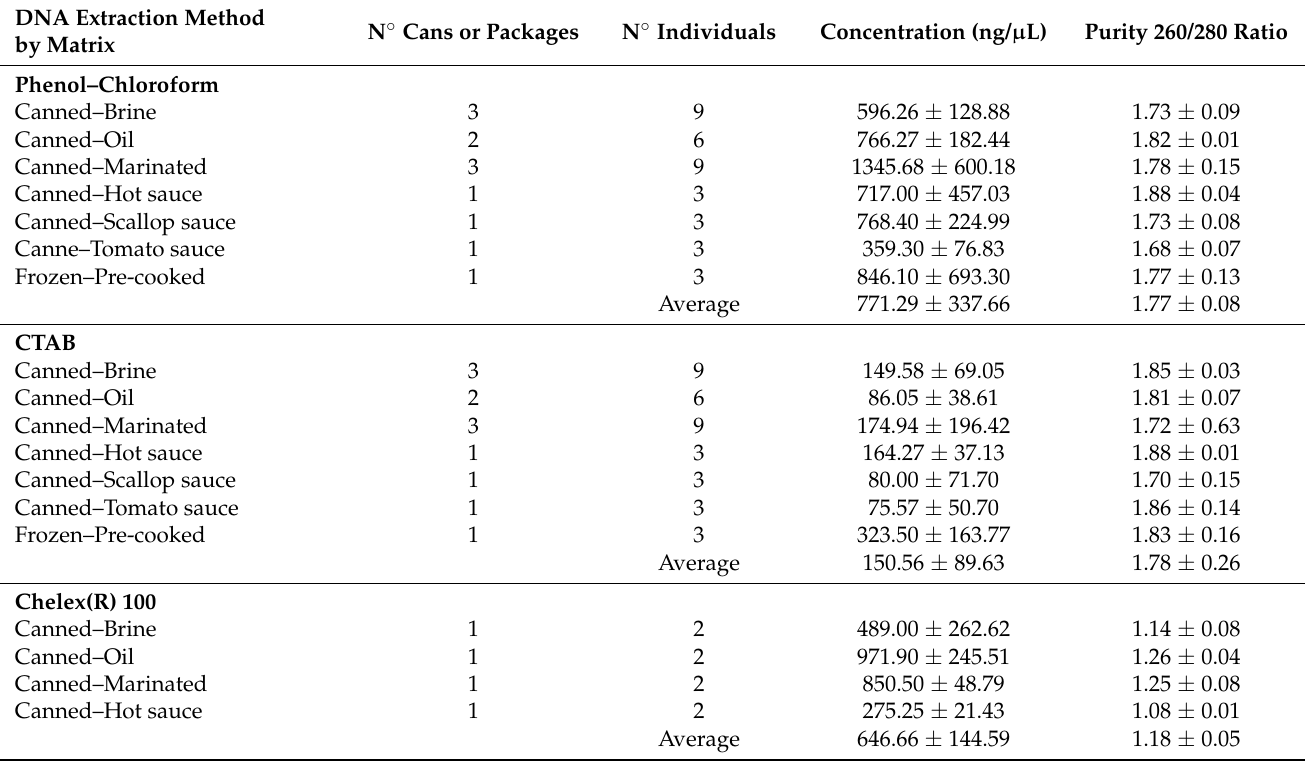
Table 3. DNA quality (concentration and purity with SD) of mussels from commercial samples obtained by different extraction